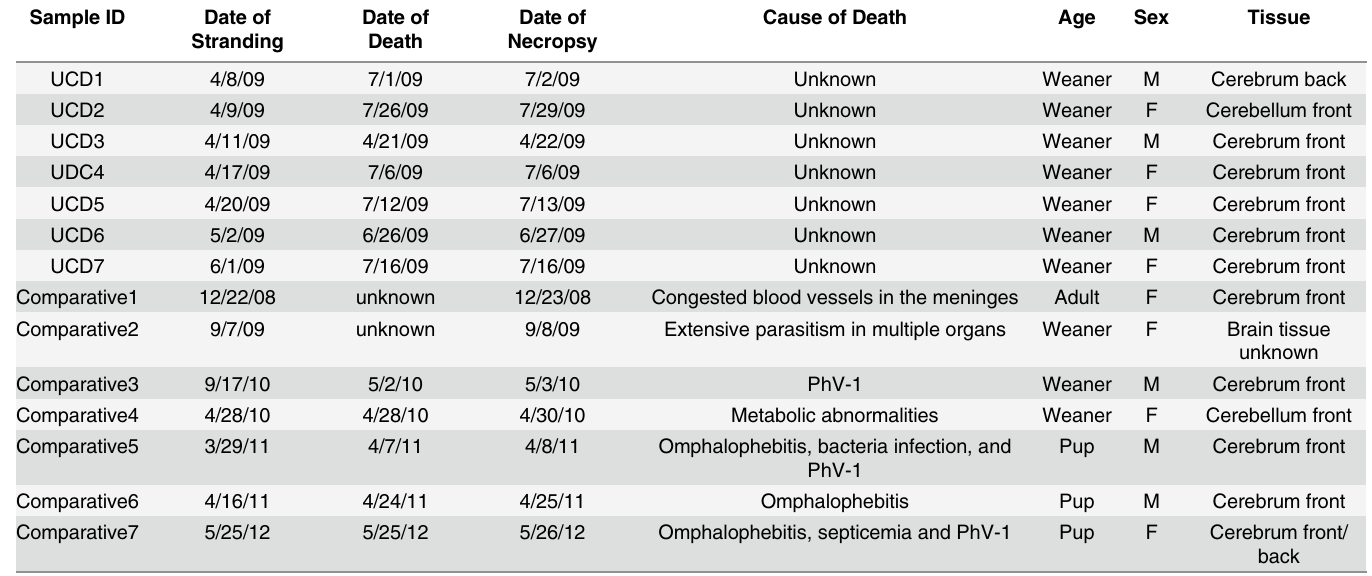
Table 1. Summary of necropsy reports and tissue types from harbor seals. PhV-1 = Phocine herpes virus -1. Age range is as follows: Pup < 1month, weaner 1 – 12 months, and adult > 3